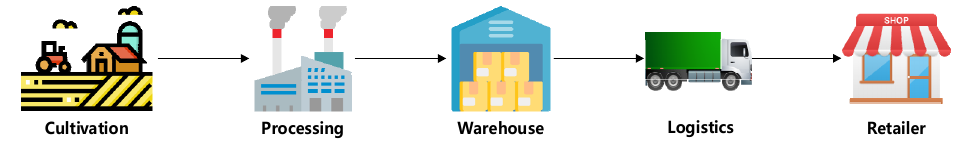
Figure 1. Typical links in the whole supply chain of grain and oil food.